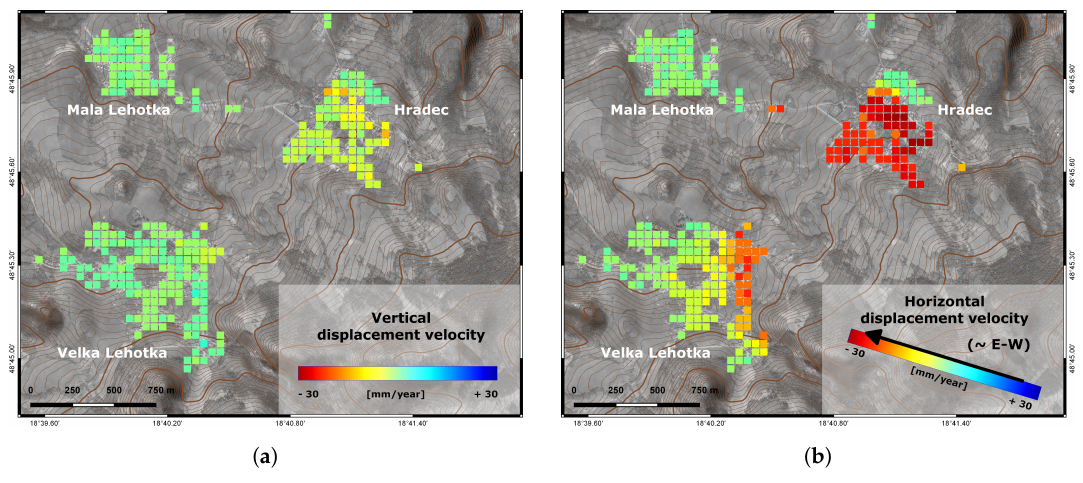
Figure 10. Decomposition of InSAR LOS velocities (Figure 8) into ( a ) vertical component and ( b ) horizontal (approximately E-W) component. Basemap: Google, 2017 CNES and ZBGIS topography, GKU